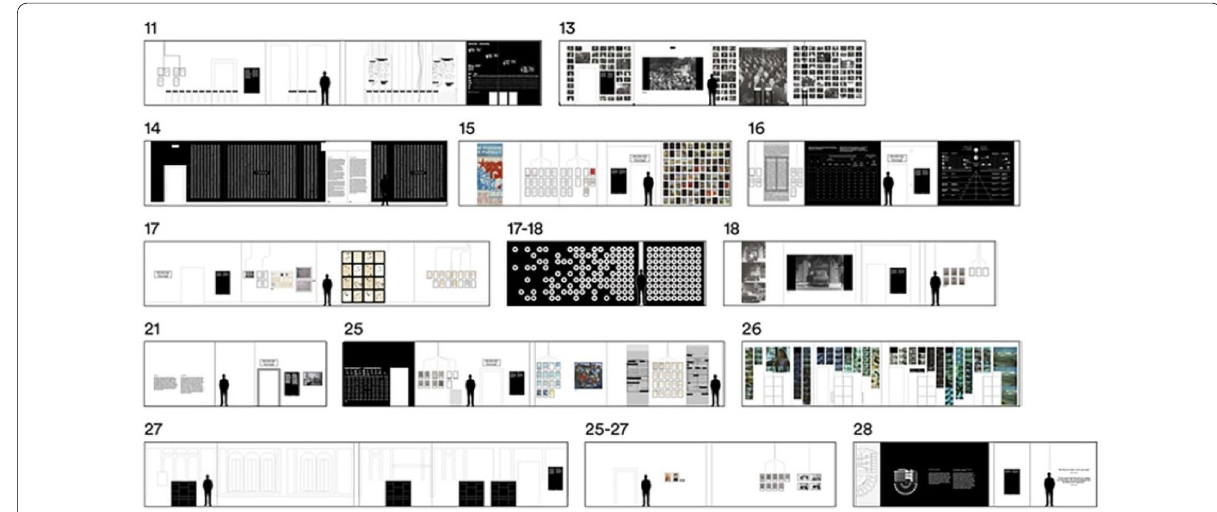
Fig. 14 The interior project of the museum “The House of Leaves”, Studio Terragni Architetti